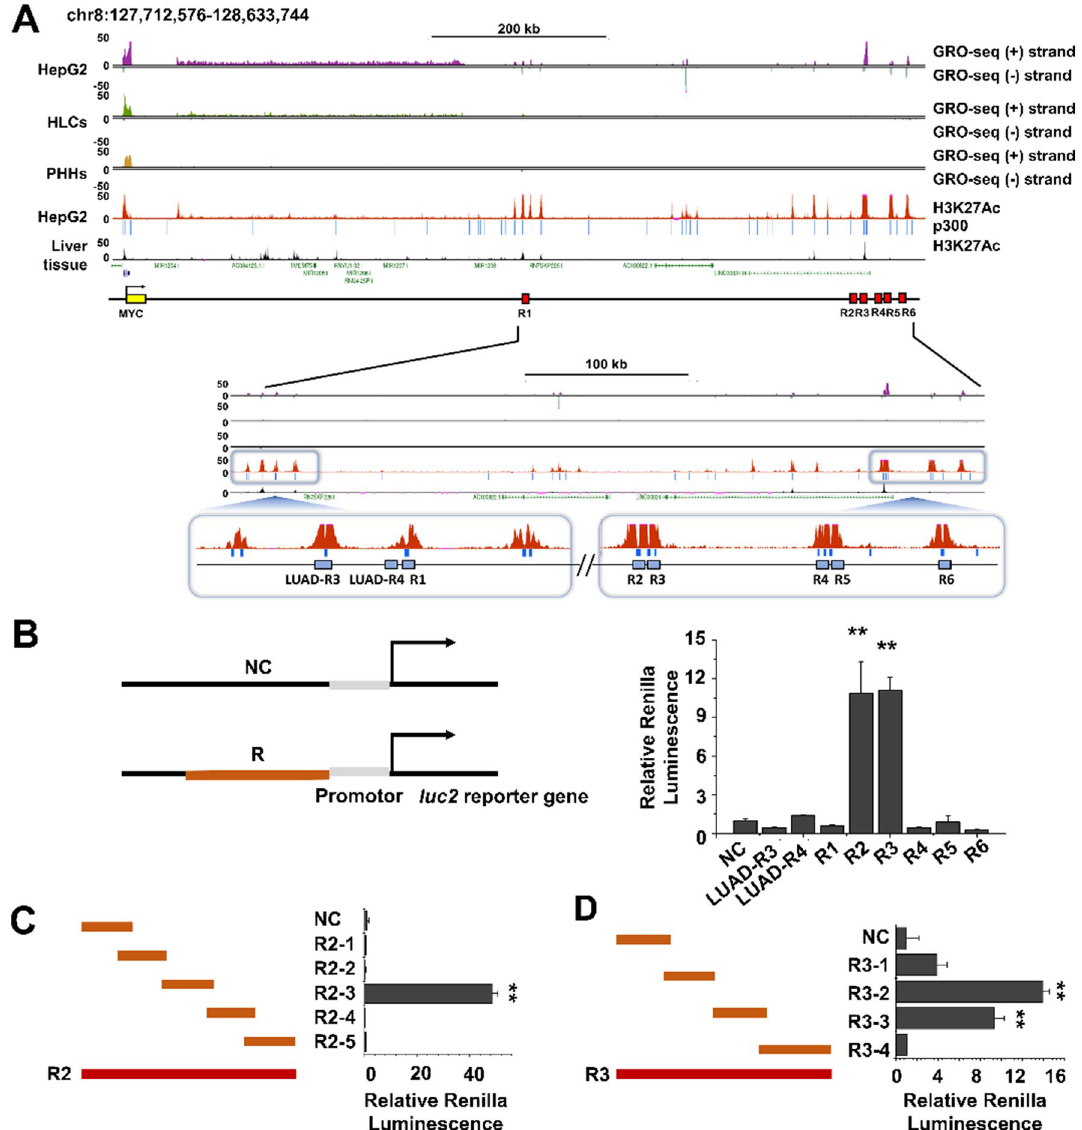
Figure 2. Identification of MYC enhancer in HepG2 cells. ( A ) USCS genome browser view of the GRO- seq peak, H3K27ac enrichment, and p300 binding sites along the MYC locus. Potential MYC enhancer is indicated + 500 kb downstream (red boxes). An enlarged display of H3K27ac-enriched reads aligned to the putative enhancer regions (GRCh38/Chr 8: 127,712,576–128,633,744). Six putative enhancer regions (R1, R2, R3, R4, R5, and R6) located downstream of the MYC gene are numbered. Hepatocyte-like cells, HLCs; primary human hepatocytes, PHHs; lung adenocarcinoma, LUAD. ( B ) Luciferase assay was used to identify the regions of active enhancers for MYC expression. These six putative enhancer regions were cloned upstream of the firefly luciferase reporter ( Luc2 gene). ( C ) The fragments of the R2 region were placed upstream of a luciferase reporter. ( D ) Fragments of the R3 region were placed upstream of a luciferase reporter. For each transfection, the firefly luciferase activity was normalized to that of the Renilla reniformis luciferase activity. The data are normalized to the pGL4.26 construct. The data represent three independent experiments. ** p < The R3-deleted cells showed reduced MYC gene expression relative to wild-type cells (Fig. 4B). Using qRT- PCR analysis, we found that R2 eRNA (R2-S) and R3 eRNA (R3-S) expression were significantly decreased (Fig. 4C), and so was the expression of lncRNA CCAT1 (Chr 8: 127,207,382–127,219,268), a gene that is not part of the same TAD (Topologically associated domains) as MYC but is known to be regulated by MYC in HCC 30 . By contrast, the expression of the neighboring lncRNA gene, PVT1, which is in the same TAD as MYC , was unaffected (Chr 8: 127,795,799–128,101,256). Similarly, FAM49B , which is not in the same TAD, was scarcely affected (Chr 8: 129,841,470–130,016,672) 31 (Fig. 4D,E). We then analyzed the expression of two more MYC- related genes, IRF2 and TERT , which are known to be repressed and activated by MYC, respectively 32,33 . In agreement, we found that IRF2 was upregulated in R3-deleted cells; however, TERT was downregulated (Fig. 4F).